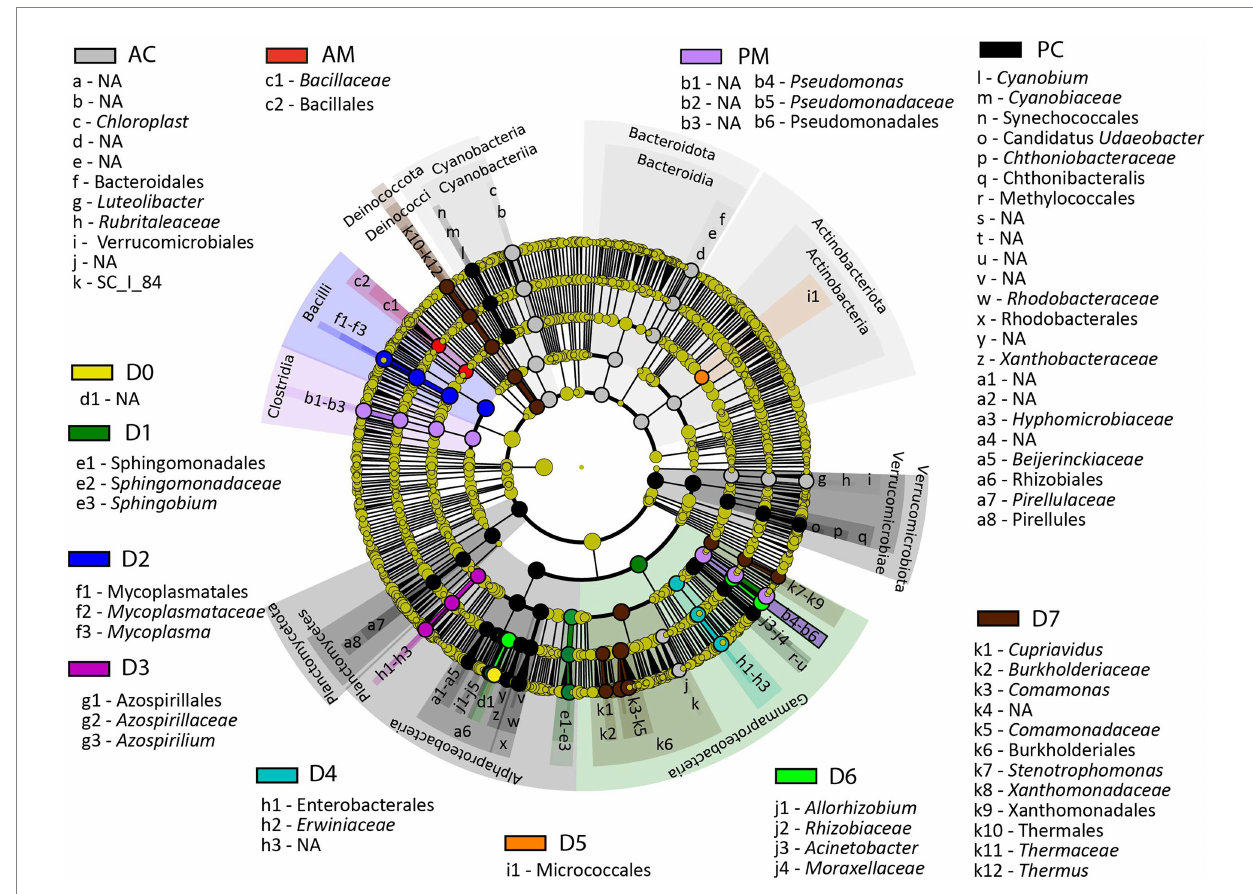
FIGURE 7 LEfSe results presenting the identified ASV that showed significant differences in abundances between the analyzed groups. AC, anterior content; PC, posterior content; AM, anterior mucosa; PM, posterior mucosa; NA, not